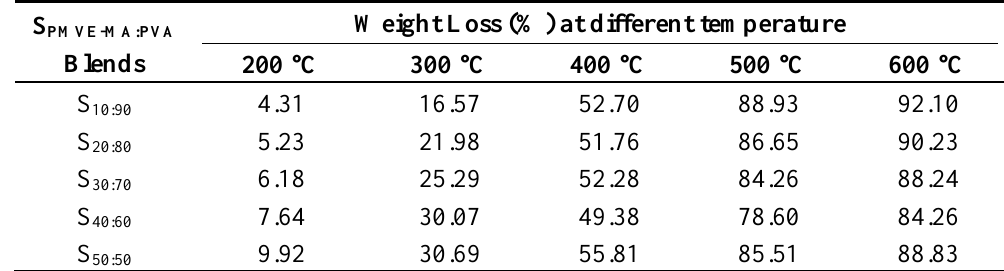
Table 2. TGA results of weight loss of the PVA/PMVE-MA blend polymer membranes at various temperatures.